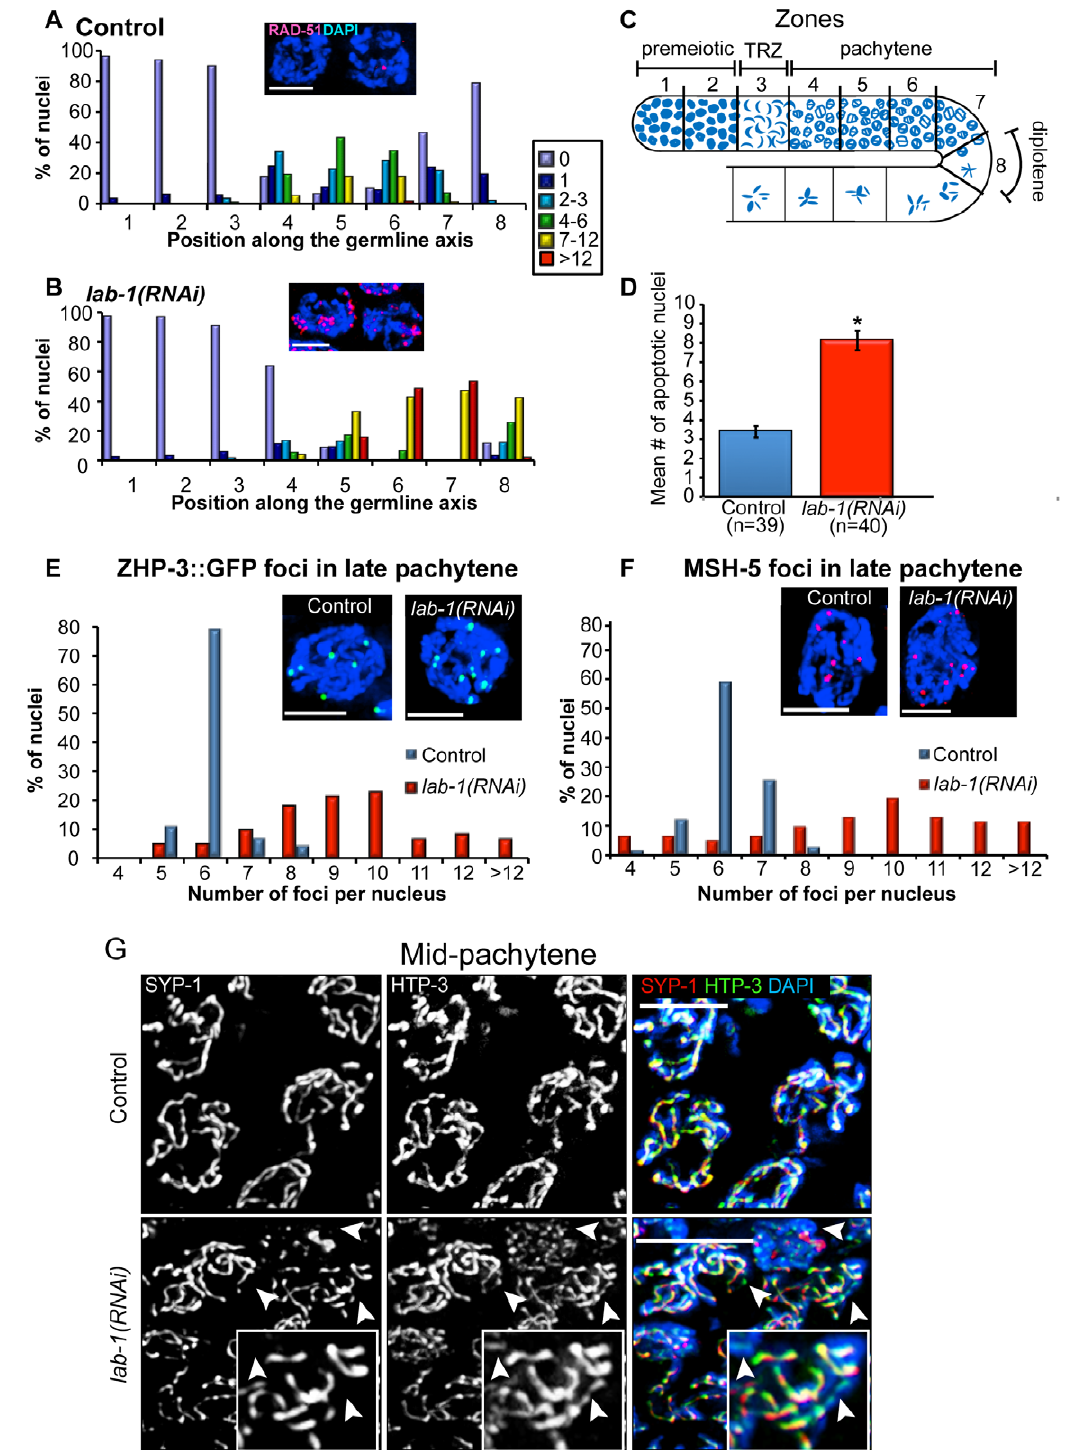
Figure 2. LAB-1 is required for double-strand break repair progression, crossover control, and complete synapsis. (A–B) Histograms depict the quantification of RAD-51 foci in (A) control and (B) lab-1(RNAi) germlines. The number of RAD-51 foci per nucleus is categorized according to the color code shown on the right. The percent of nuclei observed for each category ( y -axis) is depicted for each zone along the germline axis ( x - axis). Insets represent examples of late pachytene nuclei co-stained with DAPI (blue) and RAD-51 (red). Bars, 3 m M. (C) Germline diagram indicates the eight zones throughout which RAD-51 foci were scored for all nuclei. (D) Quantification of germline apoptosis. Error bars represent standard deviation of the mean. Asterisk indicates statistically significant increase in the number of apoptotic nuclei ( p , 0.0001, by the two-tailed Mann-Whitney test, 95% C.I.). n , number of gonad arms scored. (E–F) Histograms depict the quantification of (E) ZHP-3::GFP and (F) MSH-5 foci in late pachytene nuclei of control and lab-1(RNAi) germlines. Between 63 and 75 nuclei were scored from 5 to 7 gonads for each genotype. Insets depict representative nuclei